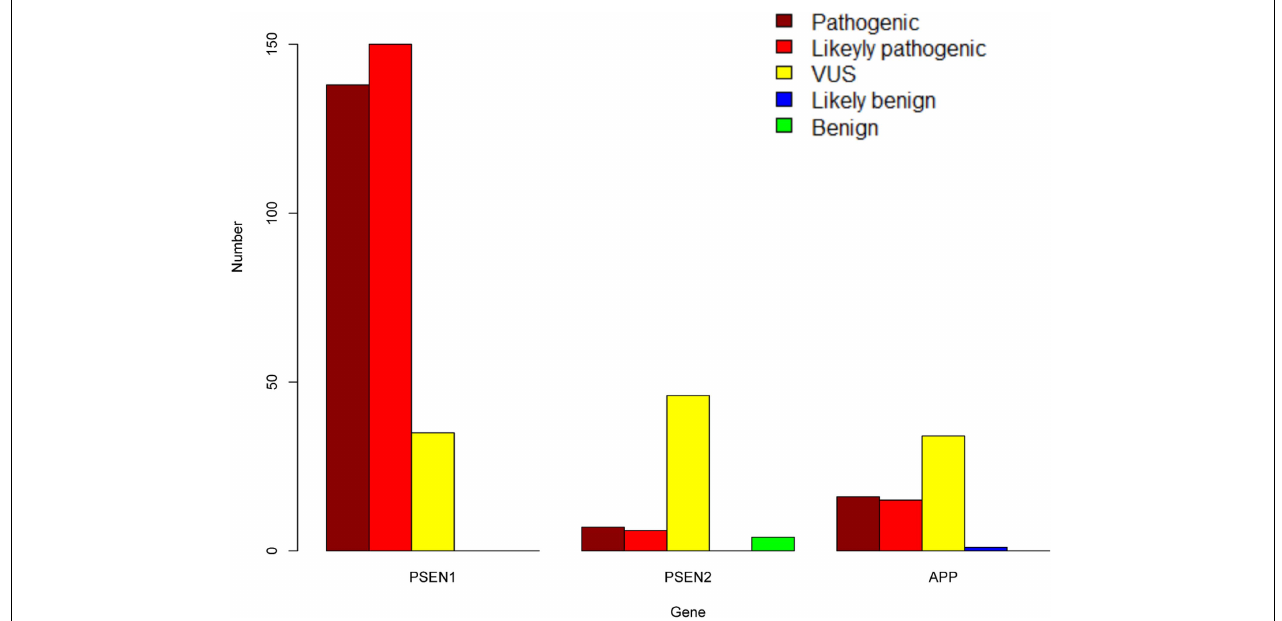
FIGURE 2 | The number of pathogenic, likely pathogenic, VUS, likely benign, and benign variants in PSEN1 , PSEN2 , and APP